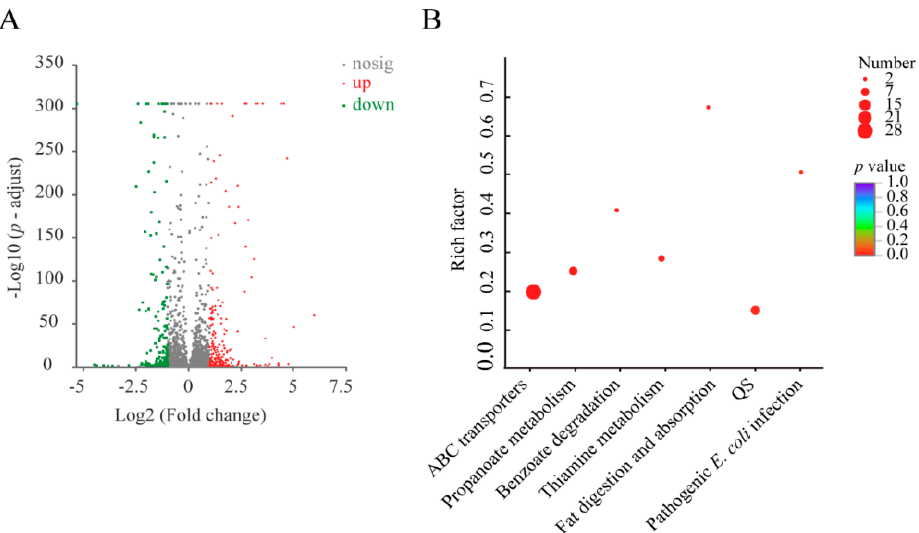
Figure 8. The major changed metabolic pathways in V. parahaemolyticus N10-18 under the Cd 2+ (50 µ g/mL) stress. ( A ) The volcano plot of differential gene expression. ( B ) The significantly altered metabolic pathways in the bacterium. The pathway of ‘pathogenic E. coli infection’ was labeled according to the catalog in the Kyoto Encyclopedia of Genes and Genomes (KEGG) database.